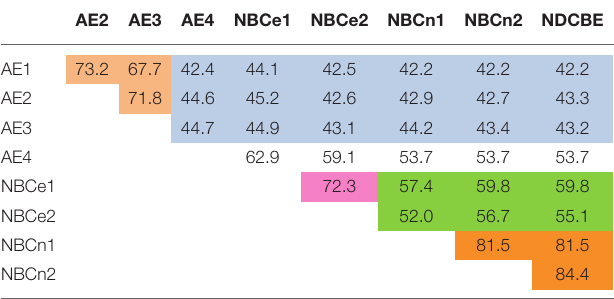
TABLE 1 | Identities of TMD among SLC4 family HCO − 3